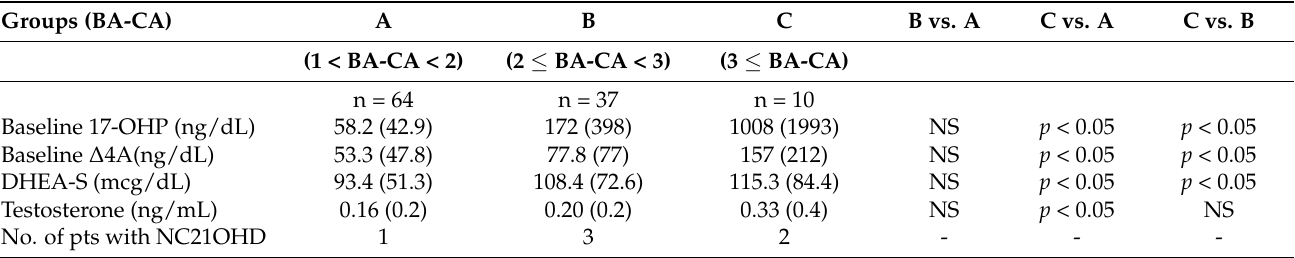
Table 3. Basal and stimulated mean (SD) 17-OHP, ∆ 4A, and DHEA-S levels among patients grouped by BA advance. NS: Not